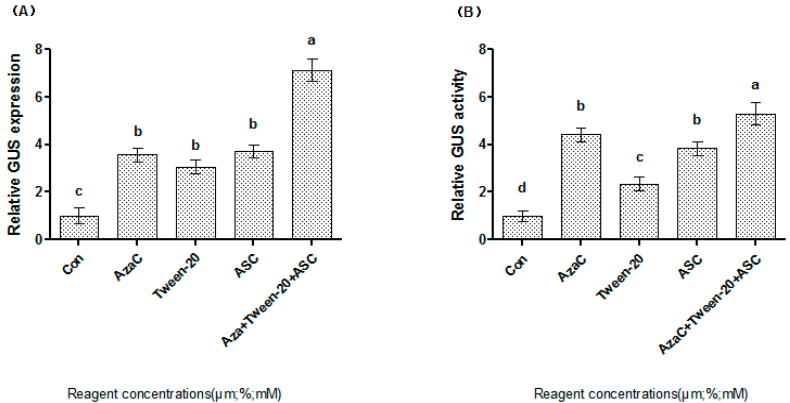
Figure 4. Analysis of the effects of Tween-20, ASC and AzaC together on syringe agroinfiltration efficiency by determination of GUS expression ( A ) and GUS activity ( B ). ( A ) Analysis of the effects of 0.03% Tween-20, 20 μ M ASC and 0.56 mM AzaC separately or together on syringe agroinfiltration efficiency by GUS expression. The expression of GUS supplied with Tween-20, ASC and AzaC together was normalized by the expression of GUS from the control experiment (no AzaC, ASC and Tween-20 supplied); ( B ) Determination of the effects of AzaC, ASC and Tween-20 together on syringe agroinfiltration efficiency using GUS activity analysis. GUS activity, when supplied with AzaC, ASC and Tween-20 together, was normalized by the activity in the control experiment. a, b, c, d means not sharing a common superscript differ significantly according to ANOVA Tukey’s test ( p < 0.05).